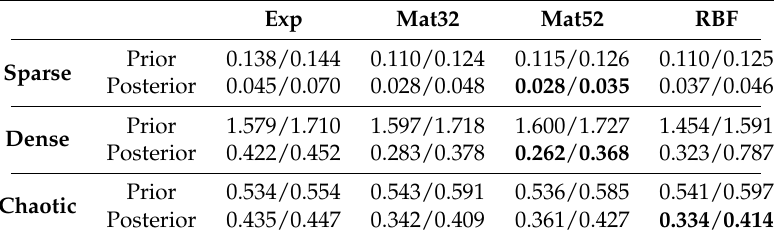
Figure 18. Diagrams of error distributions. The box-plot center box represents the interquartile range, IQR = Q 1 Q 3. The filled (resp. dot) line corresponds to the median (resp. mean). The upper − (resp. lower) whisker corresponds to the largest (resp. lowest) value at a distance below (resp. above) 1.5 times the IQR. Values above and below the whiskers are outliers drawn as circles. Table 3. Medians/means of error distributions. Bold values corresponds to minima. Exp